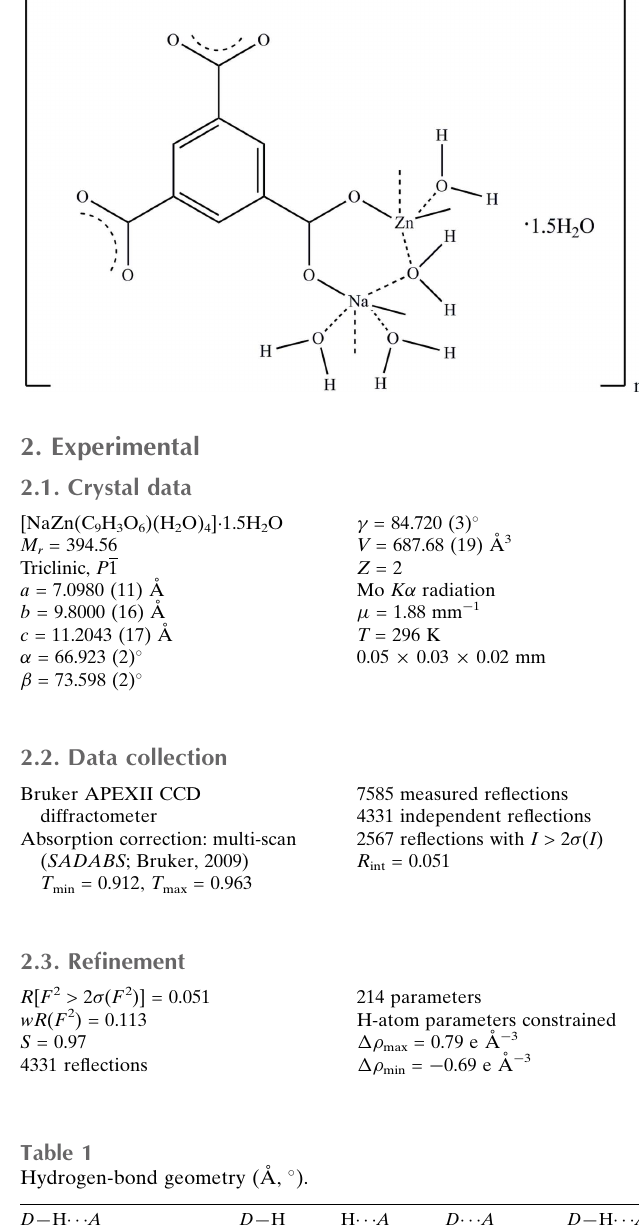
coordination polymer,